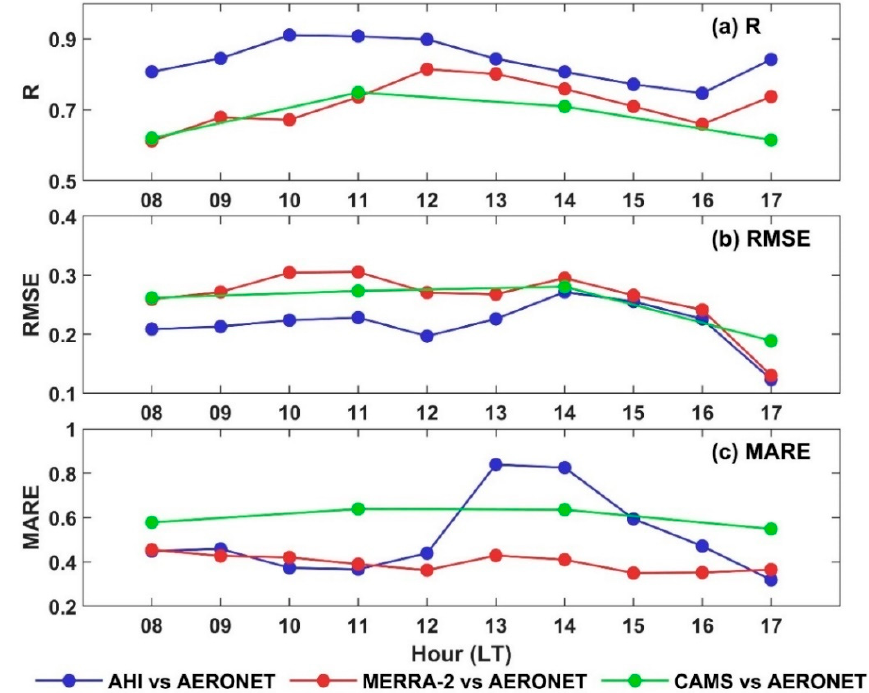
Figure 7. Diurnal variations of ( a ) R, ( b ) RMSE, and ( c ) MARE from AHI (blue), MERRA-2 (red), and CAMS (green) AOD versus AERONET observations from 08:00 to 17:00 local time (LT).